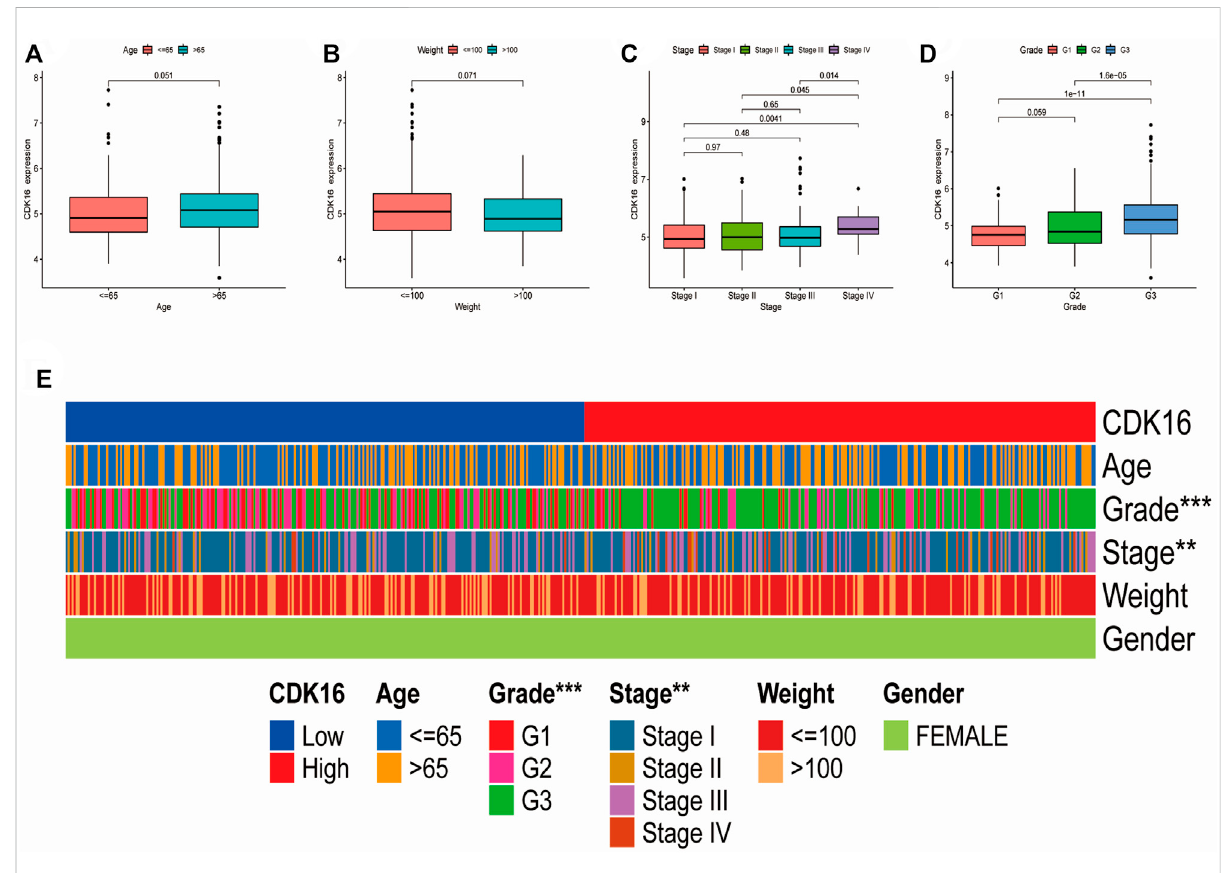
FIGURE 9 Correlation between CDK16 expression and the clinicopathological features of patients with EC: (A) age, (B) weight (C) pathological stage, (D) histological grade. (E) Heatmap demonstrating the correlation between CDK16 expression and the clinicopathological characteristics of patients with